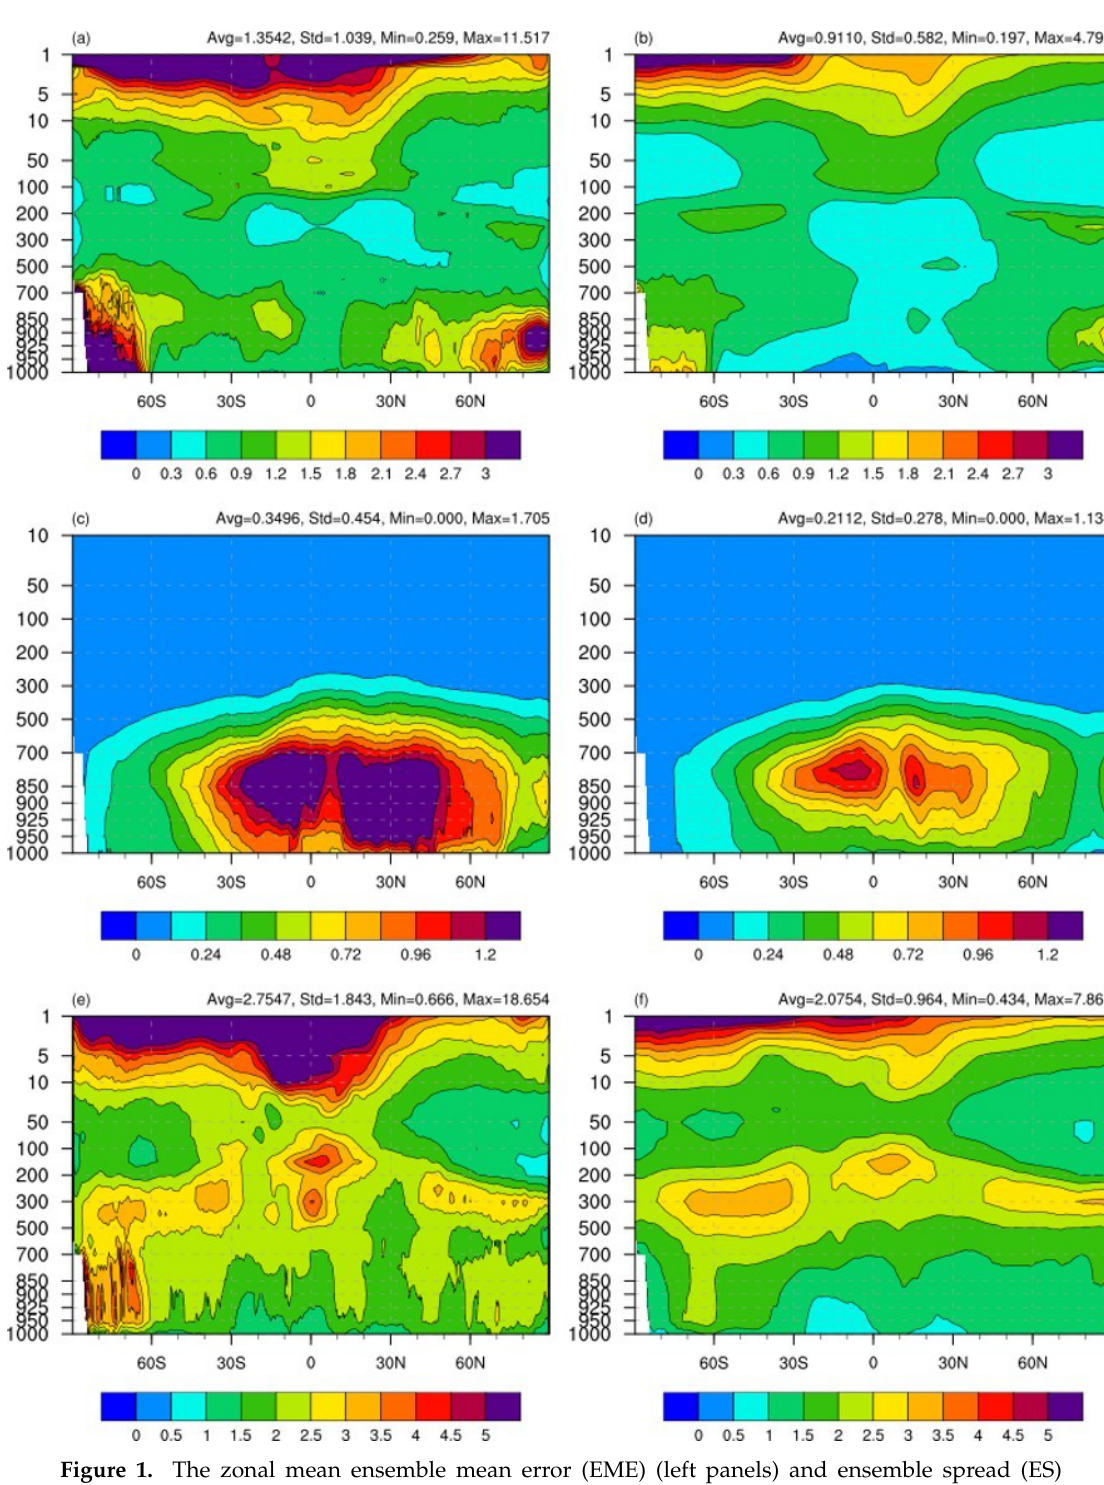
Figure 1. The zonal mean ensemble mean error (EME) (left panels) and ensemble spread (ES) (right panels) against the Integrated Forecast System (IFS) analysis for ( a , b ) temperature (in K), ( c , d ) specific humidity (in g kg − 1 ), and ( e , f ) zonal wind (m s − 1 ) as for the 6 h forecasts of the control run (CTL). Results are averaged from 18:00 UTC on 25 June 2018 to 18:00 UTC on 7 July 2018, excluding the spin-up period (first 78 h of the experiment time), with a composite of the 49 cycles’ background fields (i.e., one cycle per 6